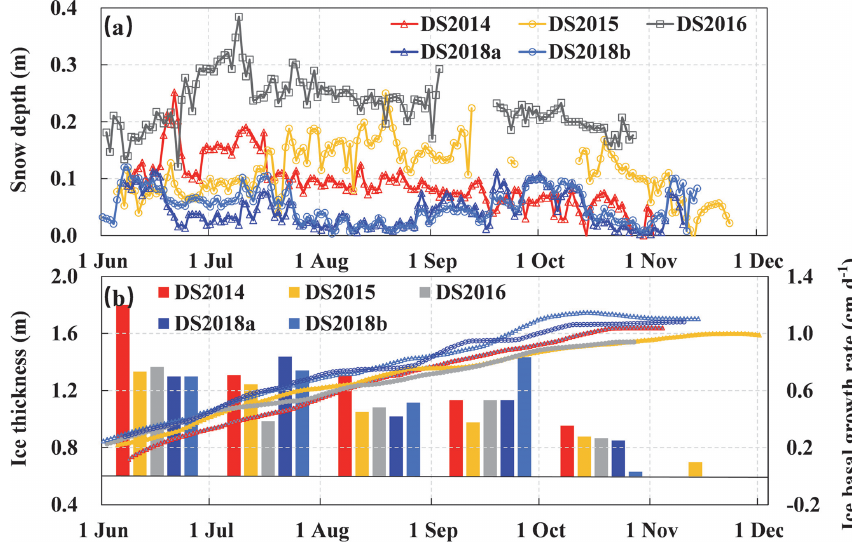
Figure 5. Same as Fig. 4, but for